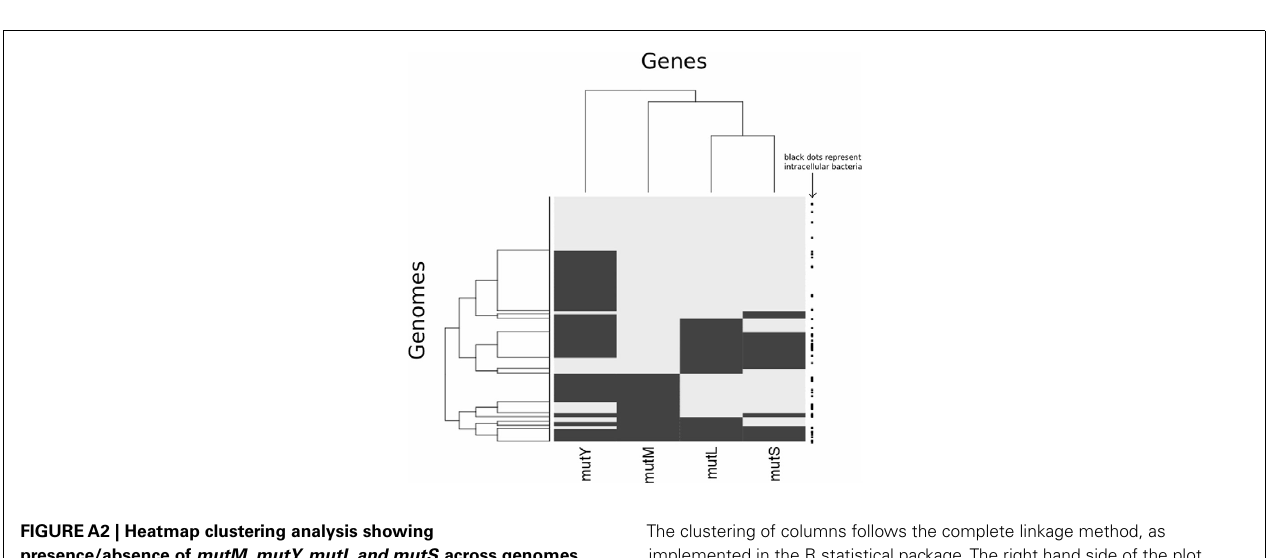
FIGUREA2 | Heatmap clustering analysis showing presence/absence of mutM, mutY, mutL and mutS across genomes. Rows represent genomes and columns represent genes. Black denotes absence of a gene in a particular genome, while gray indicates presence.